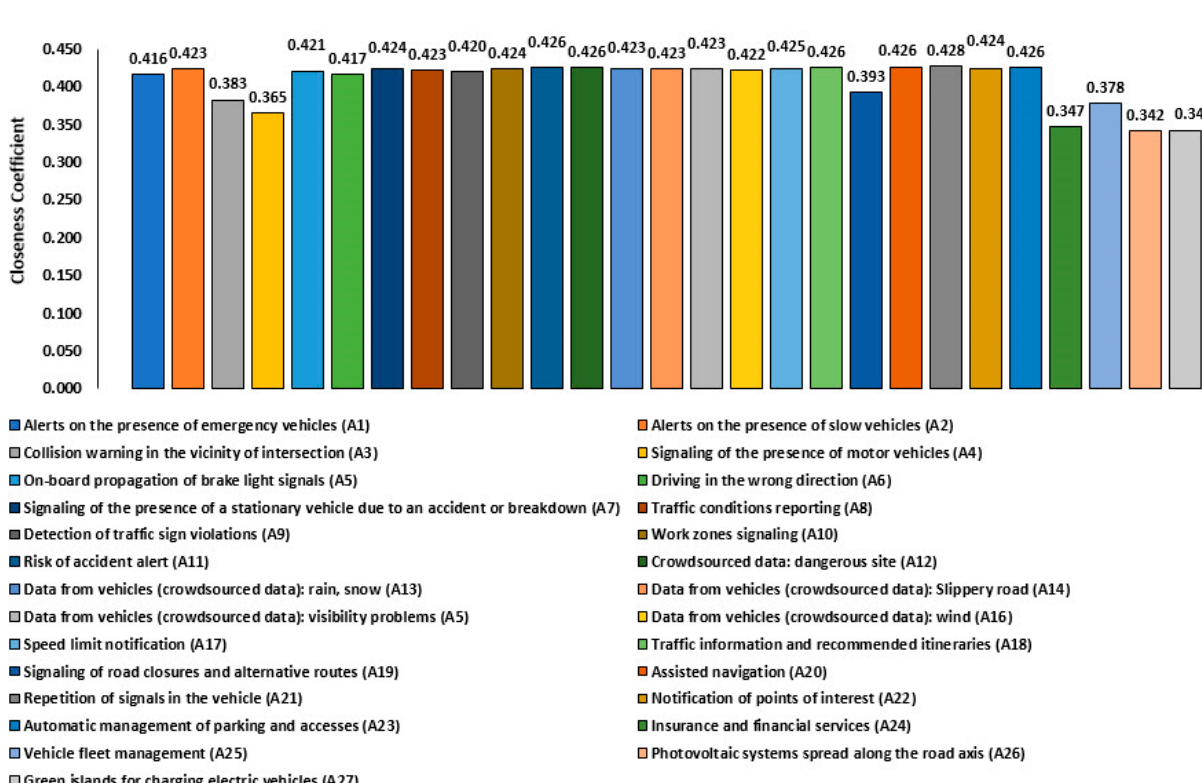
Figure 3. Ranking of 27 smartification measures with the integrated fuzzy decision support system (FDAHP-FTOPSIS).